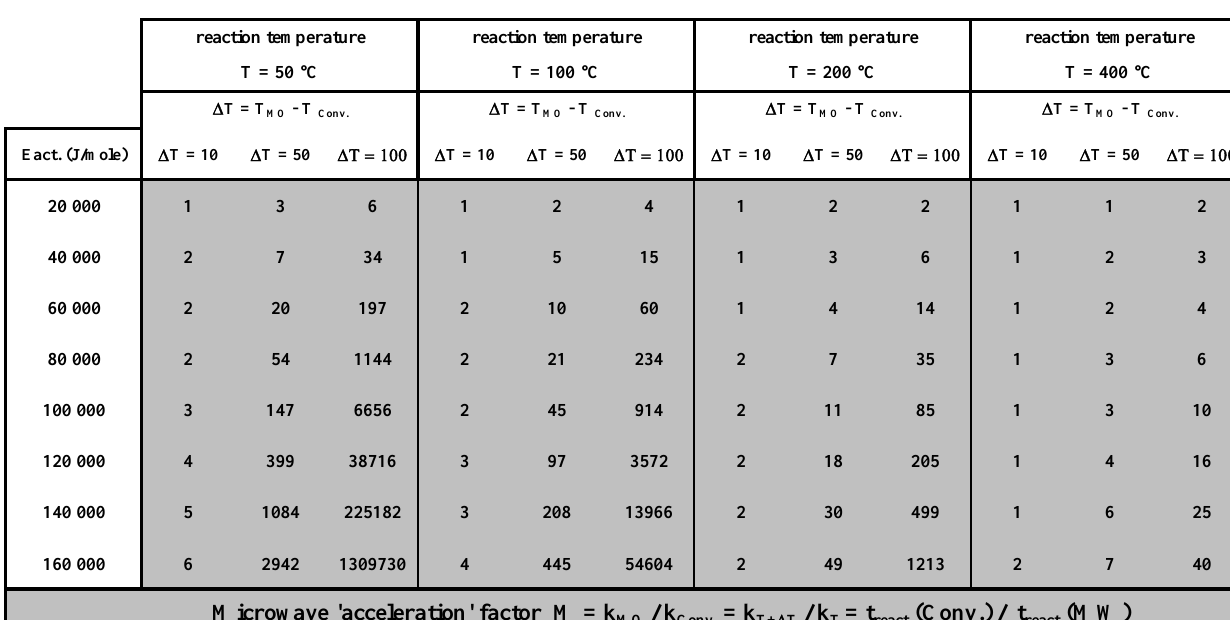
Table 2. Prediction of microwave assisted organic synthesis